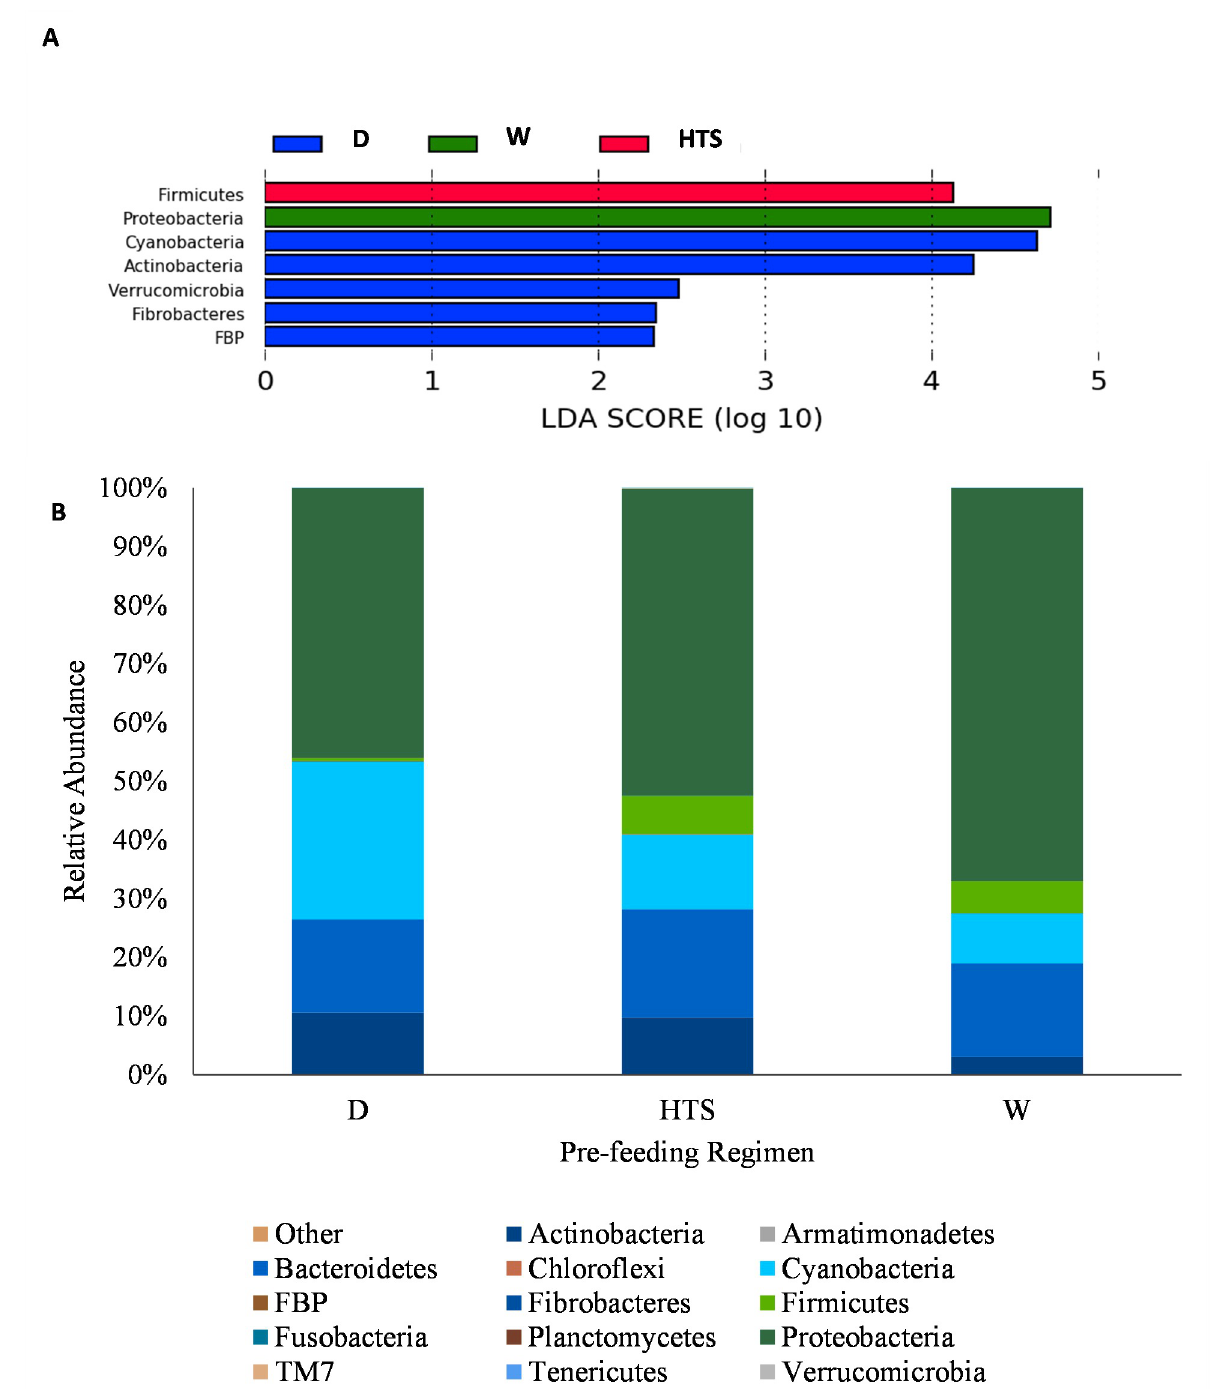
Fig 4. Effect of pre-feeding treatment regimens on relative abundance of bacterial phyla (A) between wetting regimens B) profile of bacterial abundance for the three different regimens, dry (D n = 10), HTS (n = 9) and soaked (W n = 11).